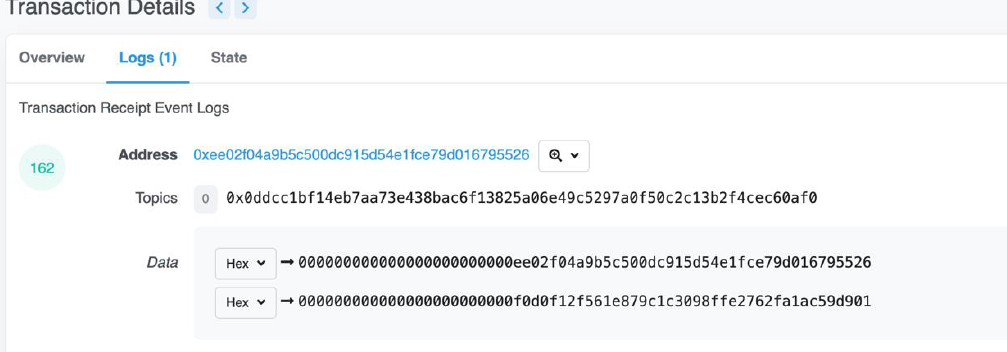
Figure A3. Logs of contract creation transaction on Etherscan.